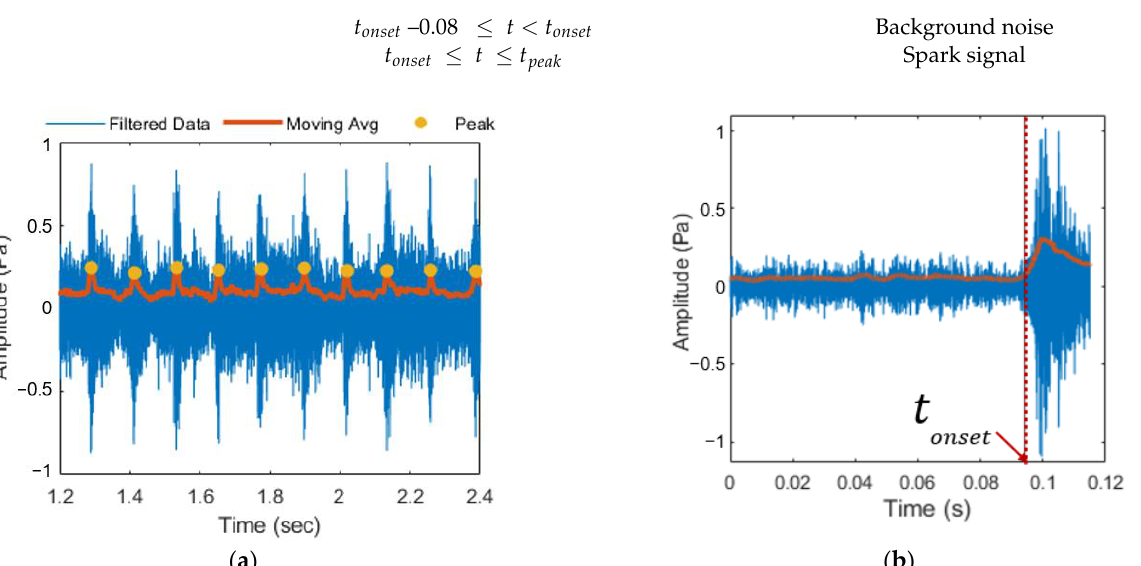
Figure 9. Moving average filter results: ( a ) series of sparks; ( b ) single spark with identified location of 𝑡 𝑜𝑛𝑠𝑒𝑡 . of t onset